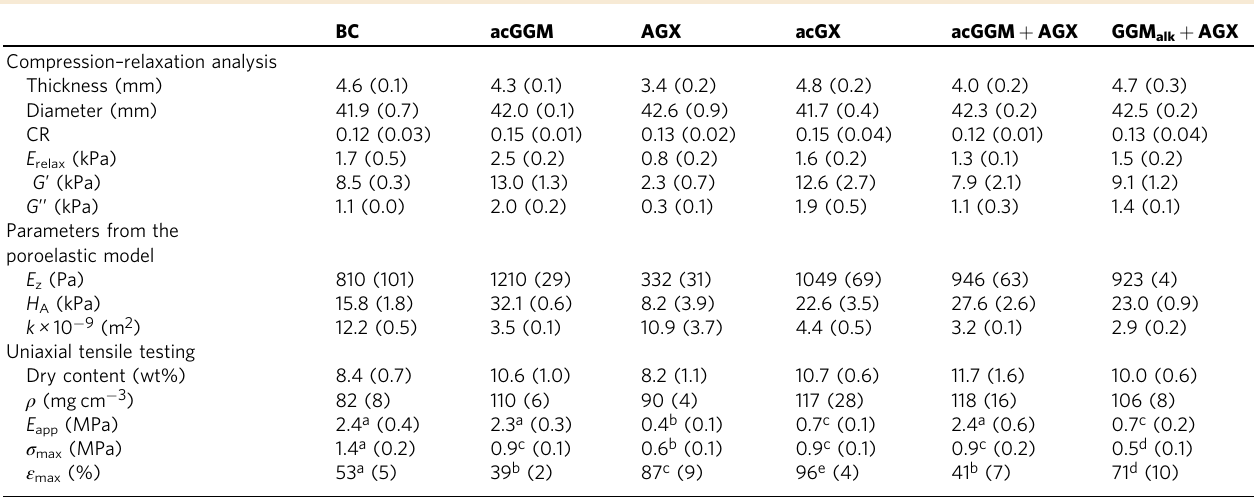
Table 1 Biomechanical properties and parameters of the poroelastic